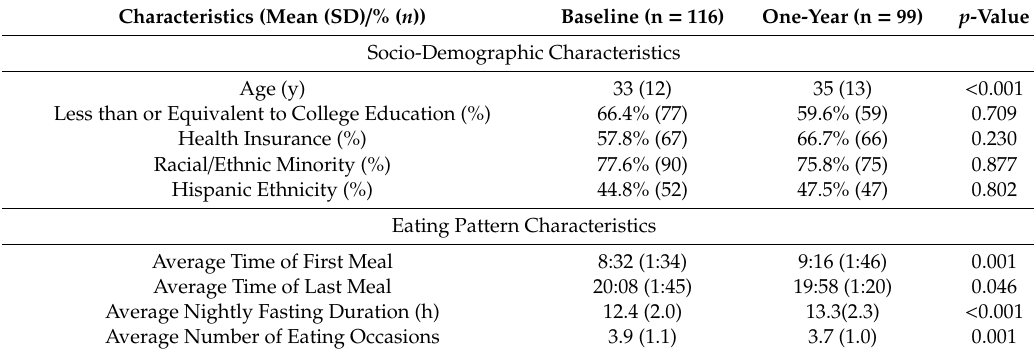
Table 1. Descriptive characteristics of the study population at baseline and follow-up a, b